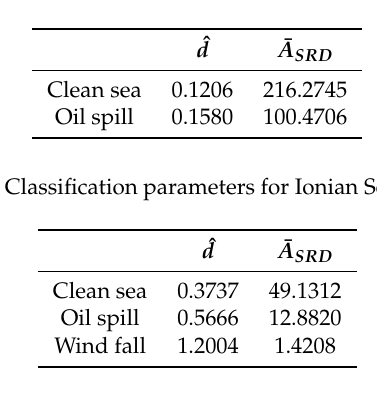
Table 1. Classification parameters for Adriatic Sea dataset.